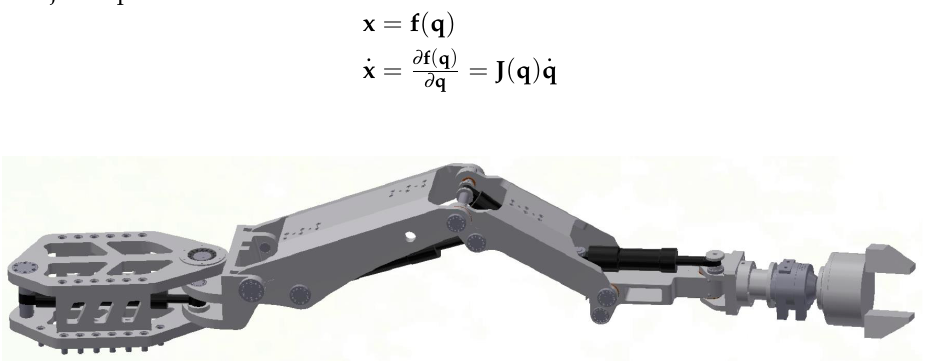
Figure 1. Architecture of the n-DOF serial hydraulic manipulator.